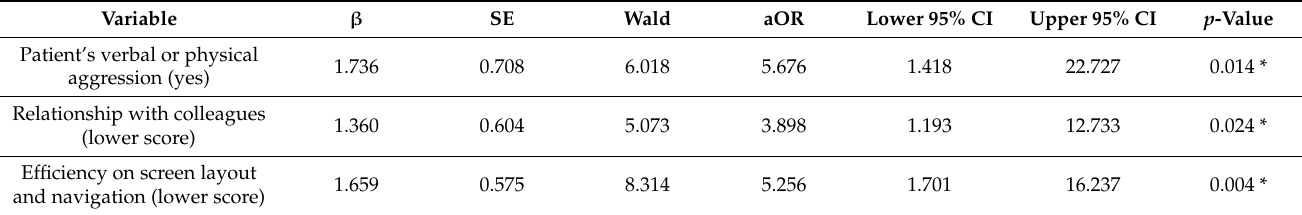
Table 4. Result of multivariate